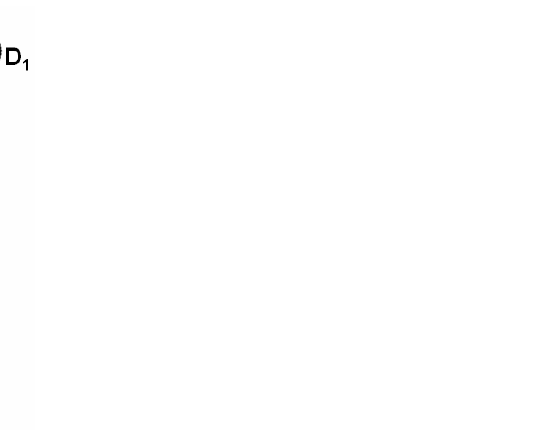
Figure 1. Mach-Zehnder interferometer and path of a photon (neutron, quantum particle). The two beam splitters are identical and have non-equal reflectivity r and transmissivity t , both being real, and subject to the condition r > t . The mirror M on the right is a mesoscopic quantum object. Of particular interest are the photons (particles) emerging toward detector D 2 . (Adapted from of